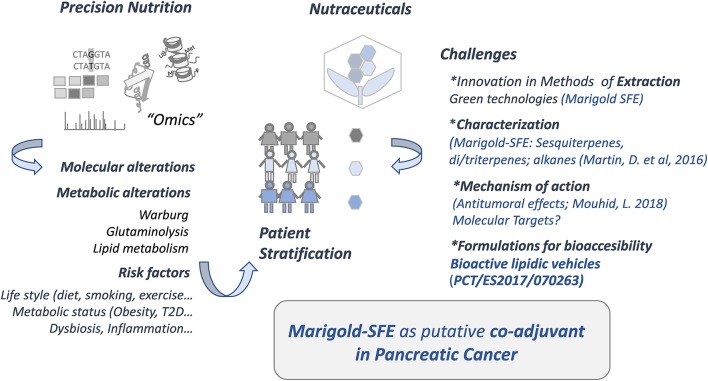
Precision nutrition and nutraceuticals.